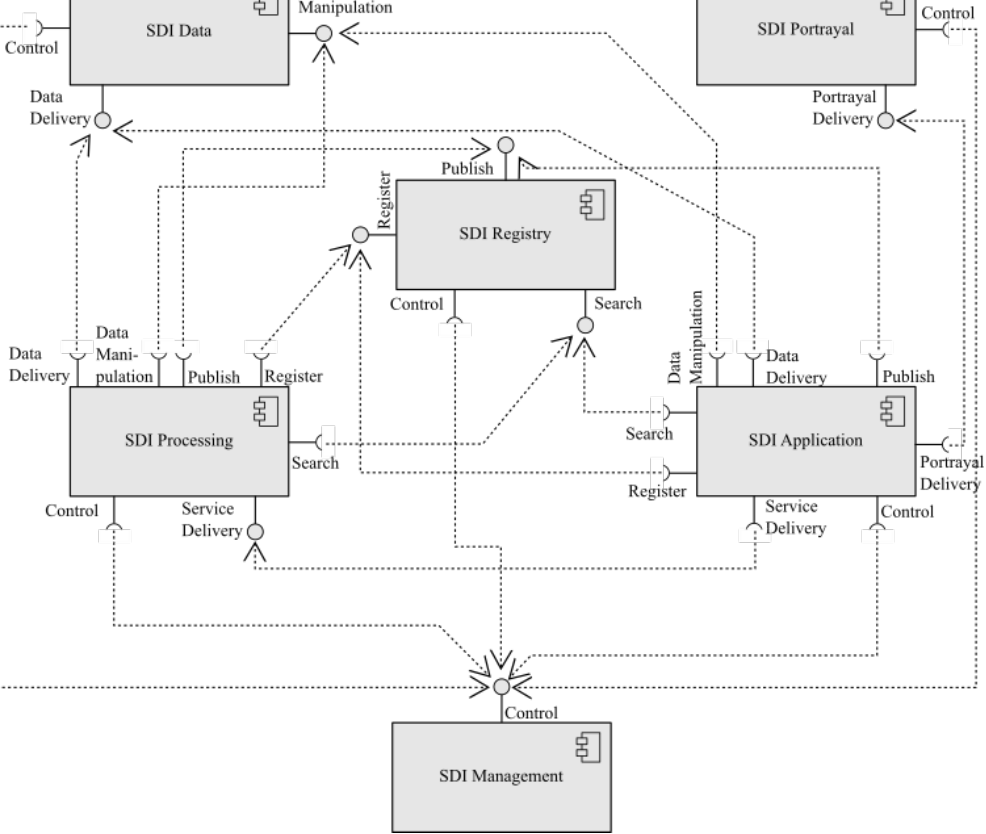
Figure 5. Diagram of components for computational objects of the SDI. Source: